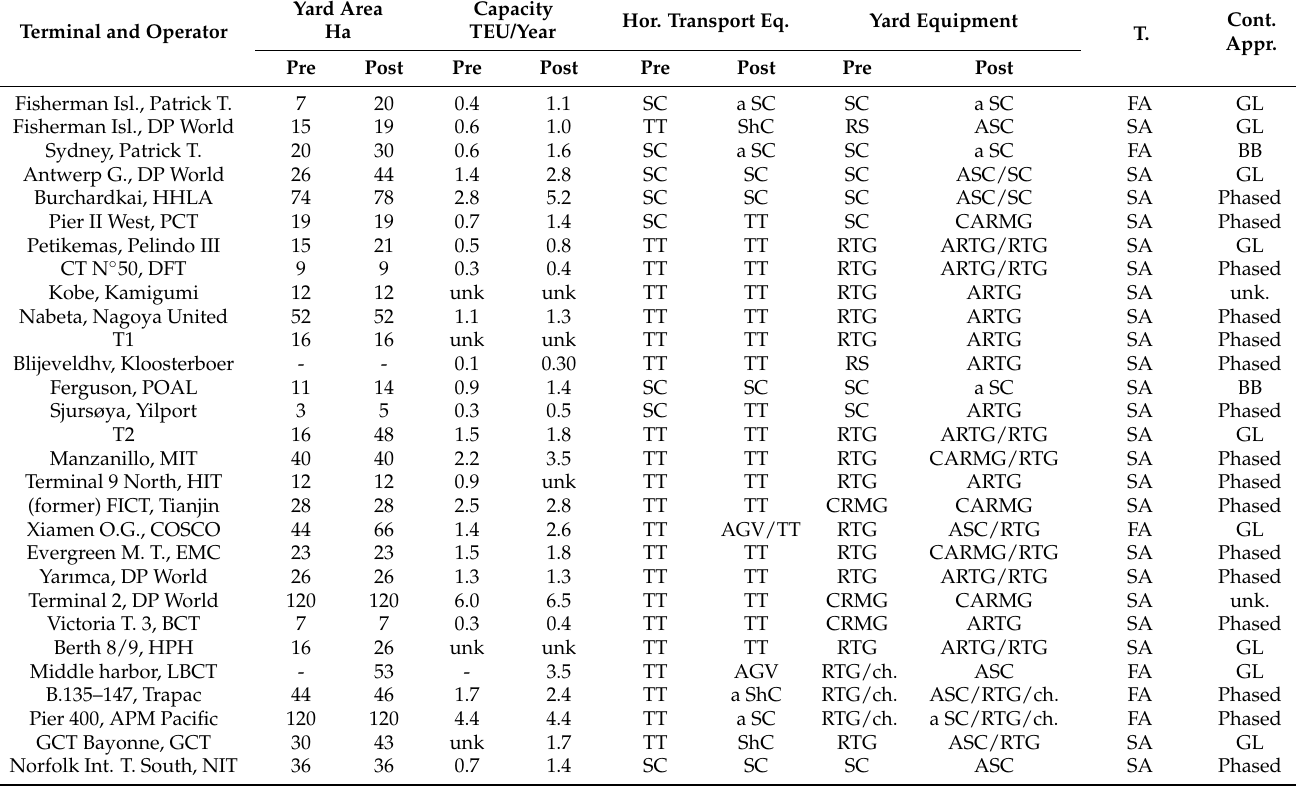
Table 2. Historically converted terminals and